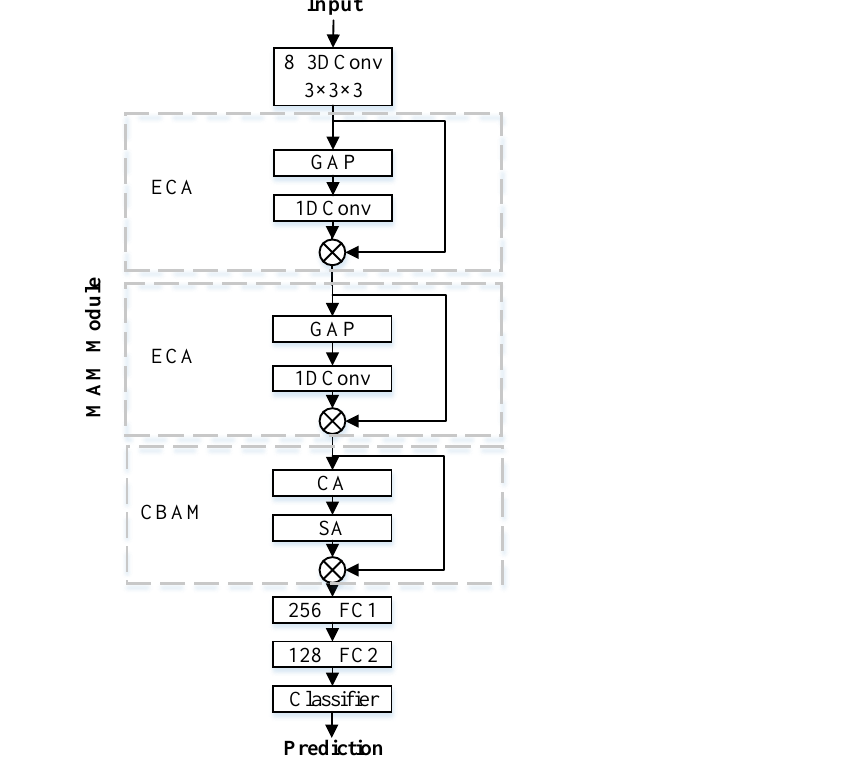
Figure 5. The main structure of the proposed MAM-3DCNN. The size of the convolutional kernel is 3 × 3 × 3, and the 8 3DConv means 3D convolution with 8 convolutional kernels. GAP is the global average pooling. ⊗ denotes the positionwise dot product. The 256 FC1 is the 1st fully connected layer with 256 neurons.